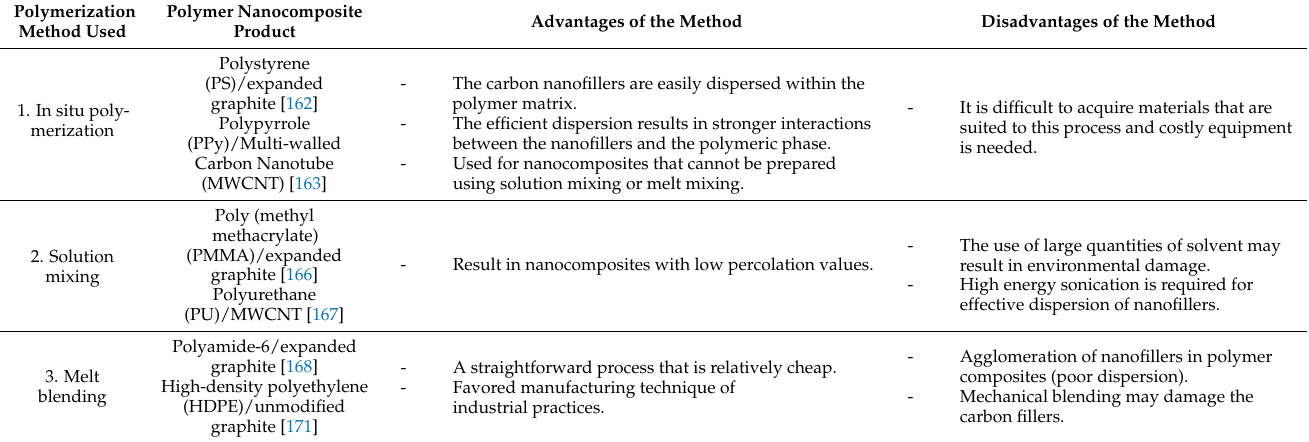
Table 11. Polymer nanocomposites prepared using in situ polymerization, solution mixing and melt blending. Polymerization Polymer Nanocomposite Method Used